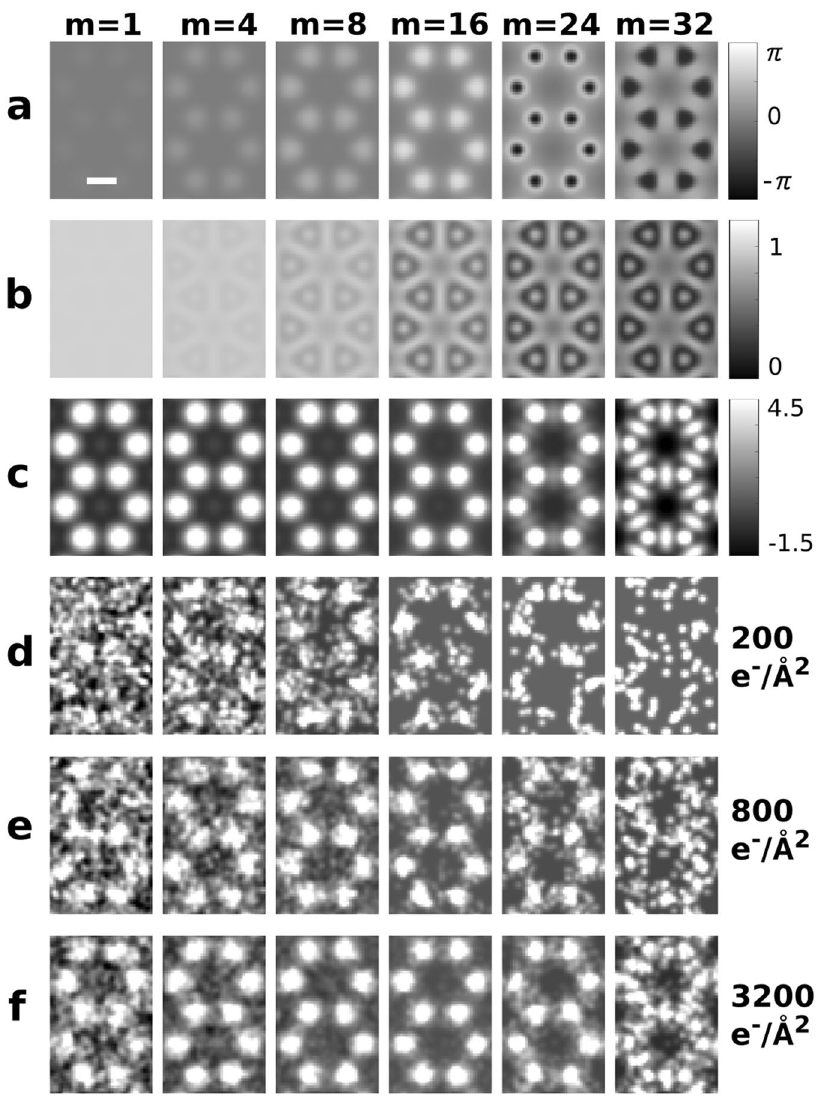
Figure 2. Multi-pass TEM simulation of graphene. ( a ) and ( b ) show the phase and amplitude of the exit wave function after a given number of passes, respectively. Simulated multi-pass phase TEM images, noise-free ( c ), and at various effective dose levels ( d–f ). The colorscale for ( c–f ) is in units of standard deviations from the mean intensity of each image. The scalebar is 0.14